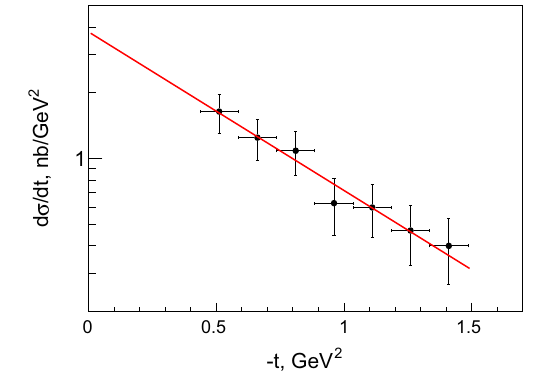
Fig. 2 The strong coupling constant α s in the analytic approach with Λ 2 = 0 . 0643 GeV